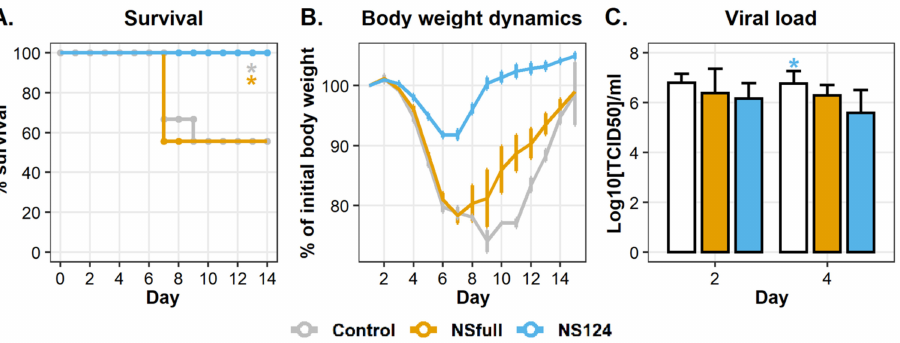
Figure 2. Survival dynamics, body weight dynamics, and lung viral titers of mice intranasally immunized with A/PR8/NSfull and A/PR8/NS124 viruses after the heterologous challenge with A/Aichi/2/68. ( A ). The Kaplan–Meier curves representing the percentage of survived animals at different time points after the challenge (*: p < 0.05, the curves were compared using the Cox method, n = 6). ( B ). Bodyweight dynamics. ( C ). Viral load (log 10 [TCID 50 ]/mL, mean ± SD, n = 4; *: p < 0.05. Groups were compared using ANOVA followed by Tukey’s post-hoc